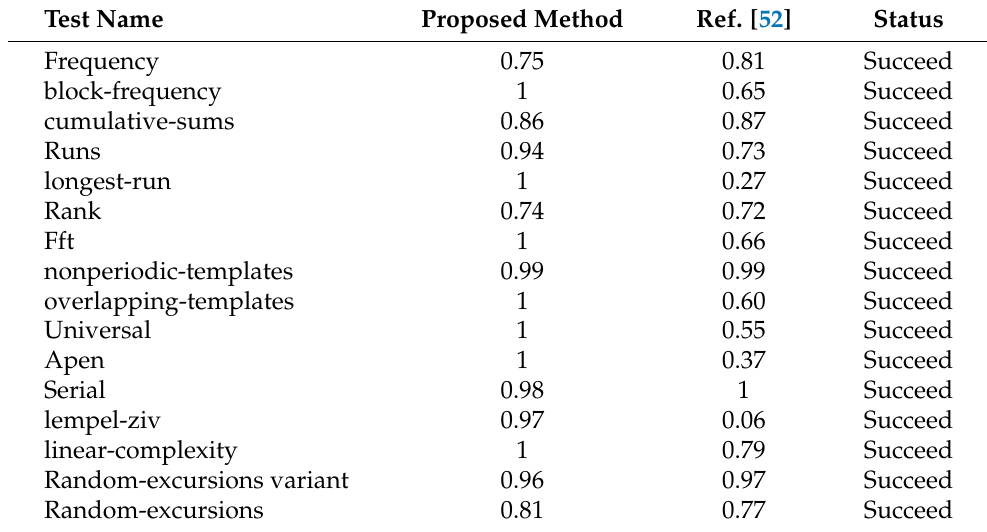
Table 10. Comparison of the proposed algorithm by NIST